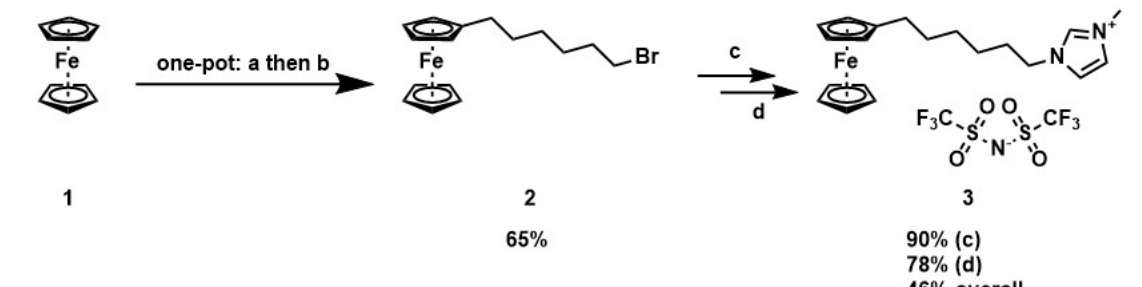
Scheme 1. Schematic representation of the synthesis of a ferrocene-containing redox-active ionic liquid via an optimized synthetic pathway. ( a ) 6-Bromohexanoyl chloride, AlCl 3 , CH 2 Cl 2 , RT, 24 h; ( b ) NaBH 4 in diglyme, CH 2 Cl 2 , 0 °C to RT, 4 h ; ( c ) N - methylimidazole, toluene, 80 °C, 18 h ; ( d ) LiTFSI, CH 2 Cl 2 /water, RT, 24 h.